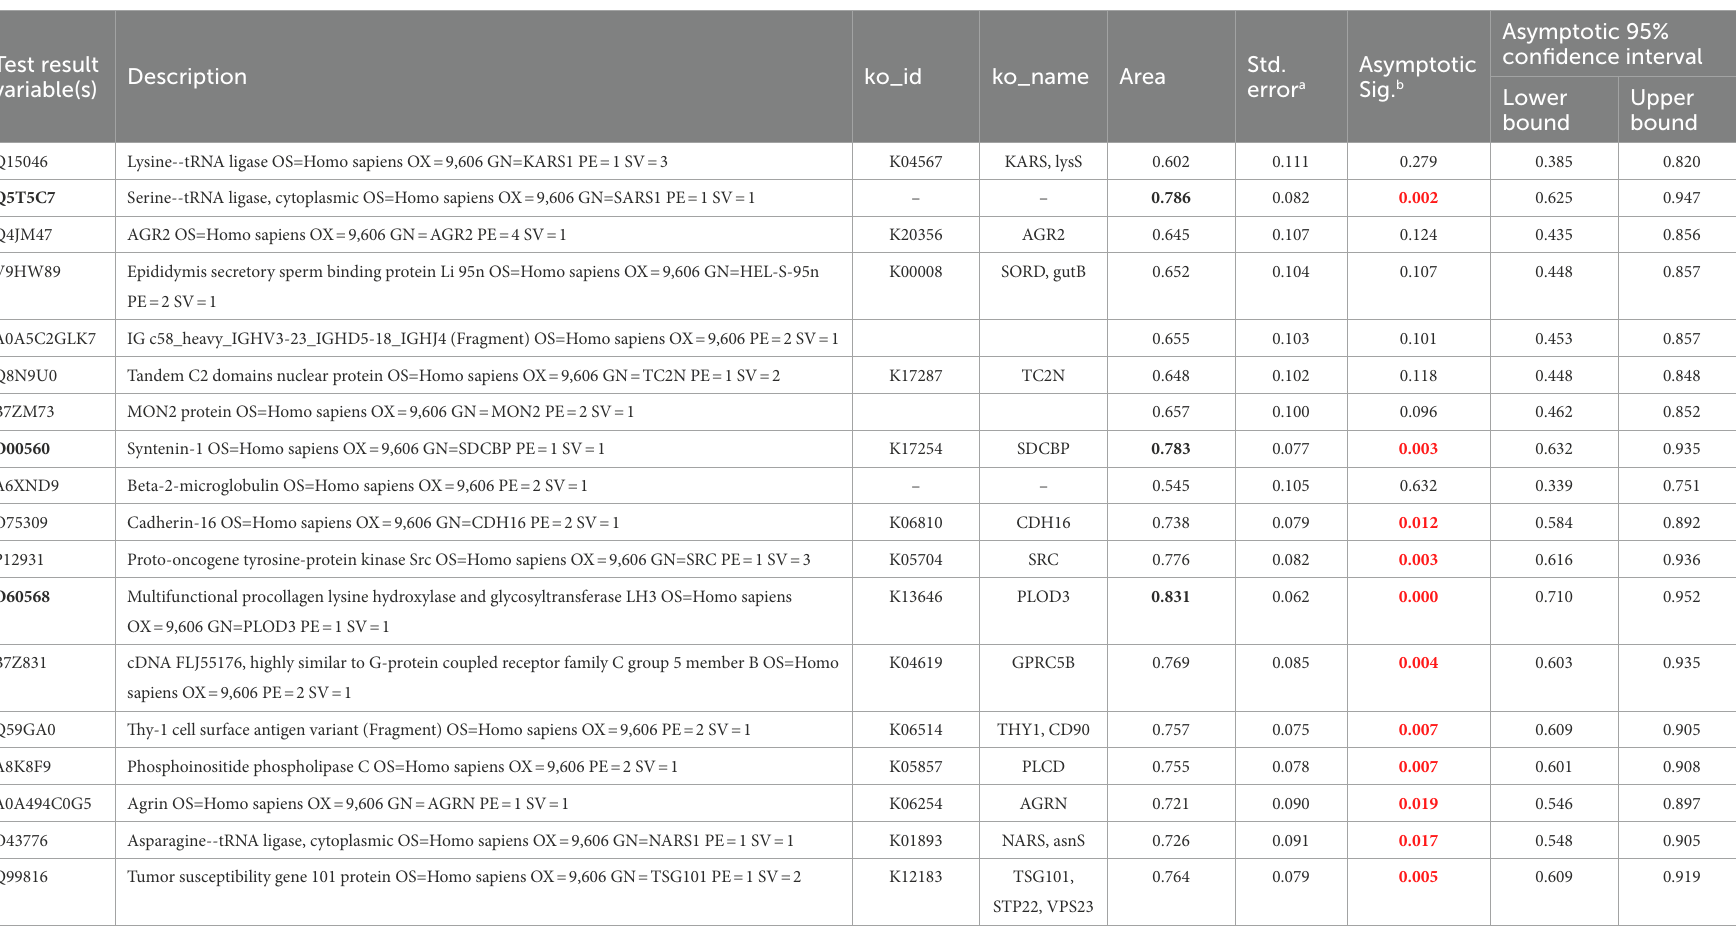
TABLE 3 AUC statistics per protein for the classification status of VD group from AD and NC groups.